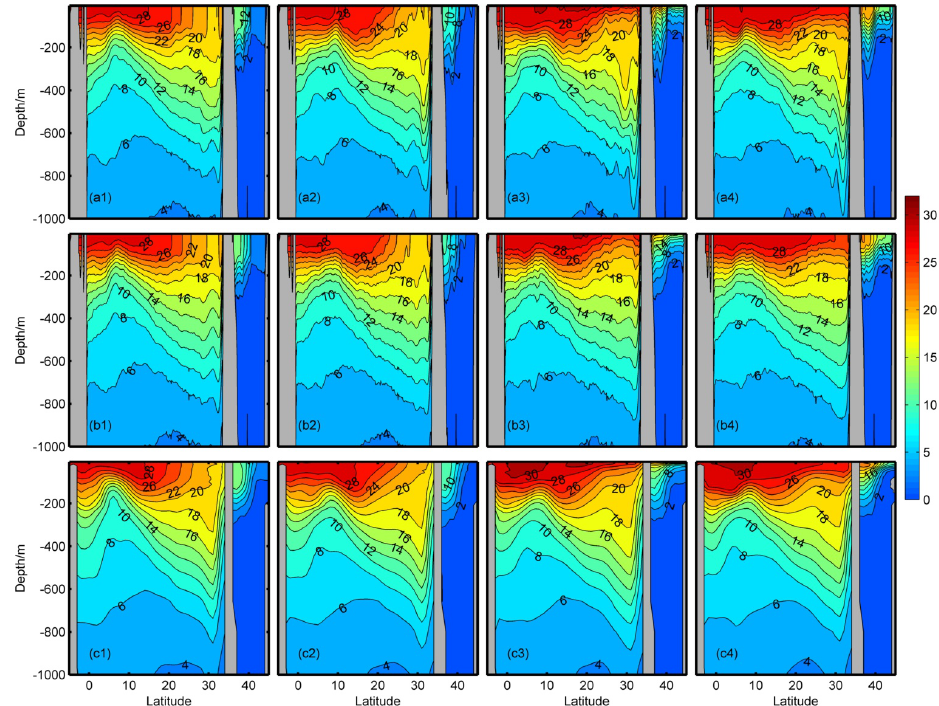
Figure 11. Distribution of temperature (in ◦ C) at transect of 137 ◦ E: (a) AF, (b) SF and (c) EN4.0.2 for (1) January, (2) April, (3) July and (4)